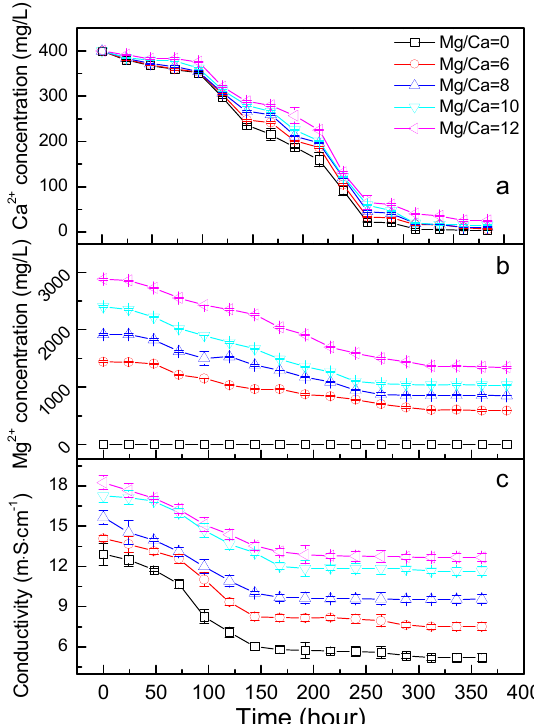
Figure 3. Ca 2+ concentration ( a ); Mg 2+ concentration ( b ); and electroconductivity ( c ) in the medium inoculated with SRB2 bacteria.